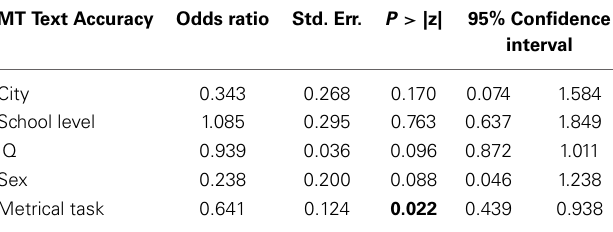
Table 5 | Logistic regressions.